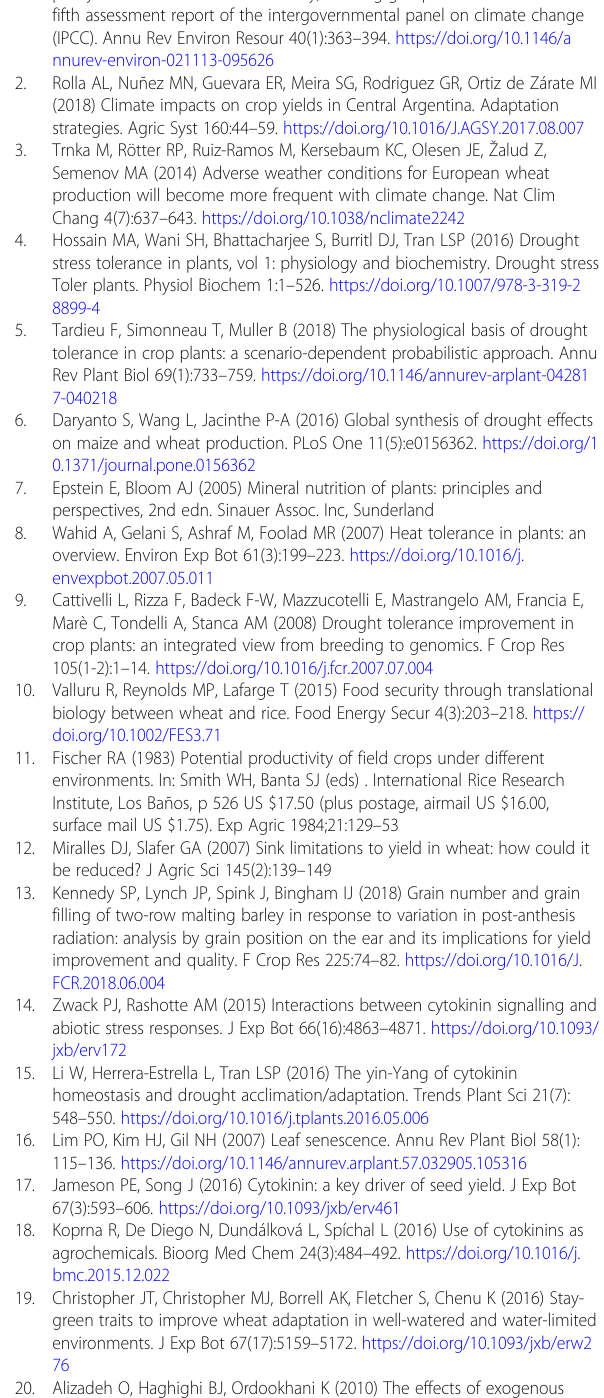
Additional file 5: Supplementary Table. 1. PCR analysis of T1 transgenic plants for IPT gene. Additional file 6: Supplementary Table. 2. Trial acronyms, Generation and Total of plants